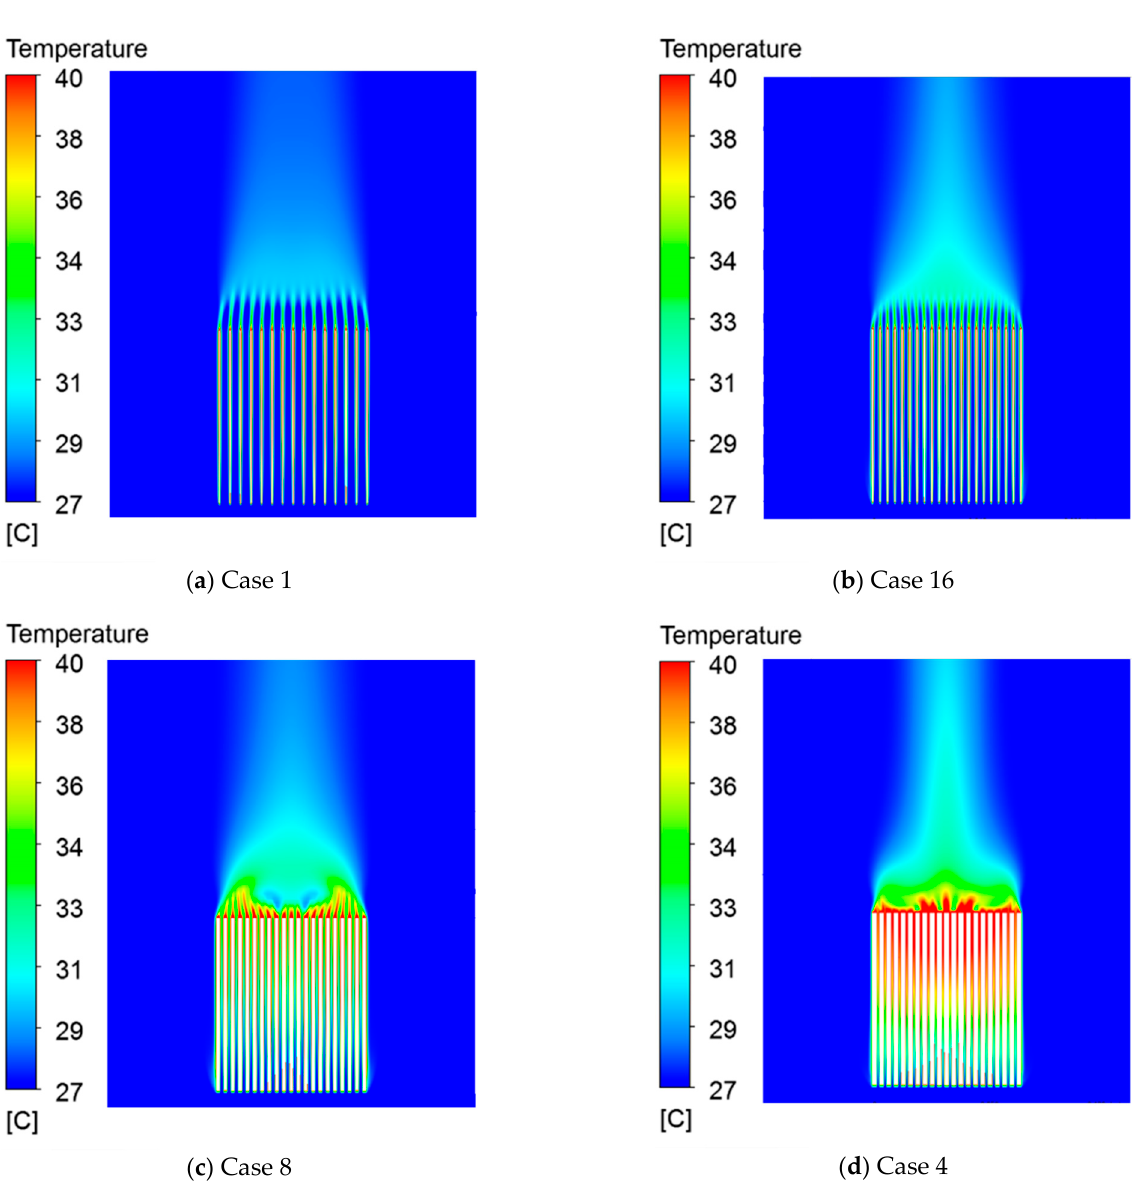
Figure 7. Temperature distribution of each case at x = 15 mm.